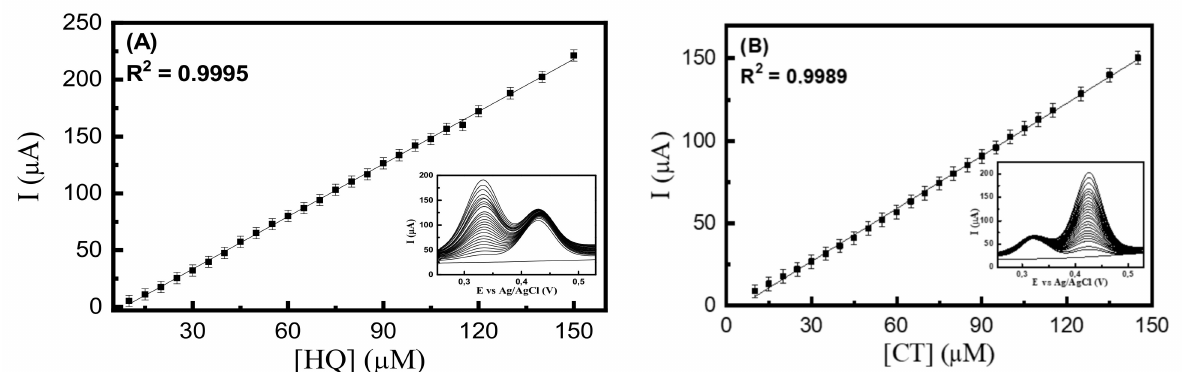
Figure 5. Oxidation voltammograms and calibration curve of ( A ) HQ in the presence of 50.0 µ M CT and ( B ) CT in the presence of 50 µ M of HQ. Working conditions: Medium Britton–Robinson pH 2.0 Swept speed: 0.004 V s − 1 , Accumulation time: 30